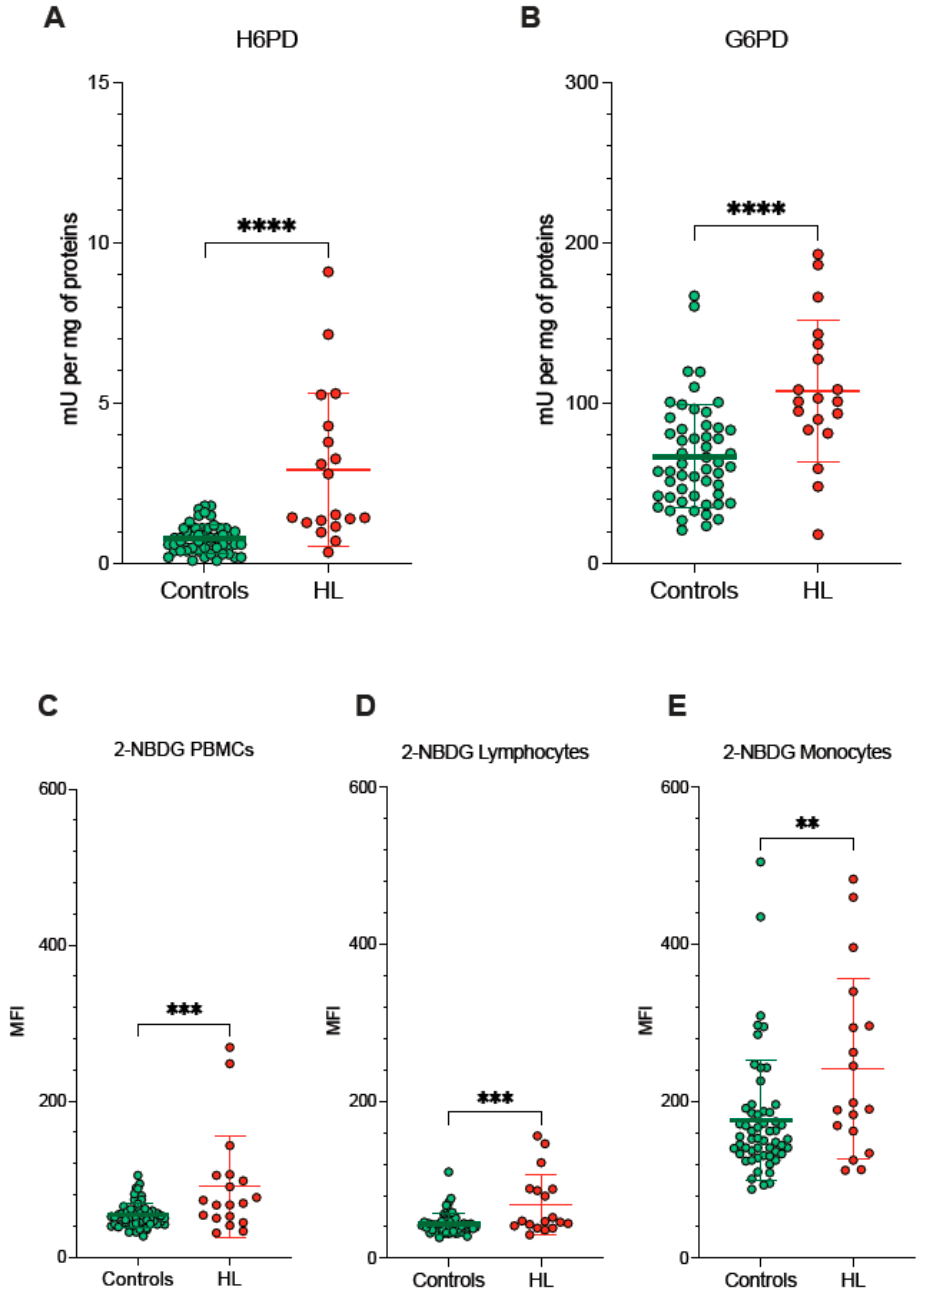
Figure 4. ER- and cytosolic- PPP activity. Catalytic function of H6PD ( A ) and G6PD ( B ), measured by enzymatic assay in lysed PBMCs sampled from controls (green) and HL patients (red). 2-NBDG uptake measured as mean fluorescence intensity (MFI) in all PBMCs ( C ), in lymphocytes ( D ) and in monocytes ( E ) of controls (green) and HL patients (red). Graphs display individual data and mean ± SD. ** = p < 0.01, *** = p < 0.002, **** = p < 0.001.